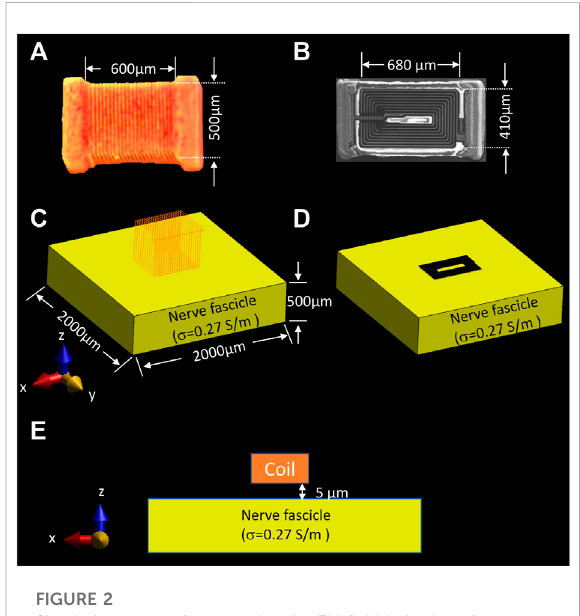
FIGURE 2 Simulation set-up for assessing the EM fi eld behavior of two different types of coil geometries on the nerve. (A) dimension of the solenoidal chip inductor; (B) top view of the planar spiral coil scanned with Scanning Electron Microscope (SEM) and its dimension; electromagnetic simulation set-up of the (C) solenoidalcoil,and (D) planar spiral coil placed on top ofthenerve surface with 5 µm distance, (E) front view of the nerve fascicle and position ofthecoil.(Panel A was recreated fromGolestanirad etal.